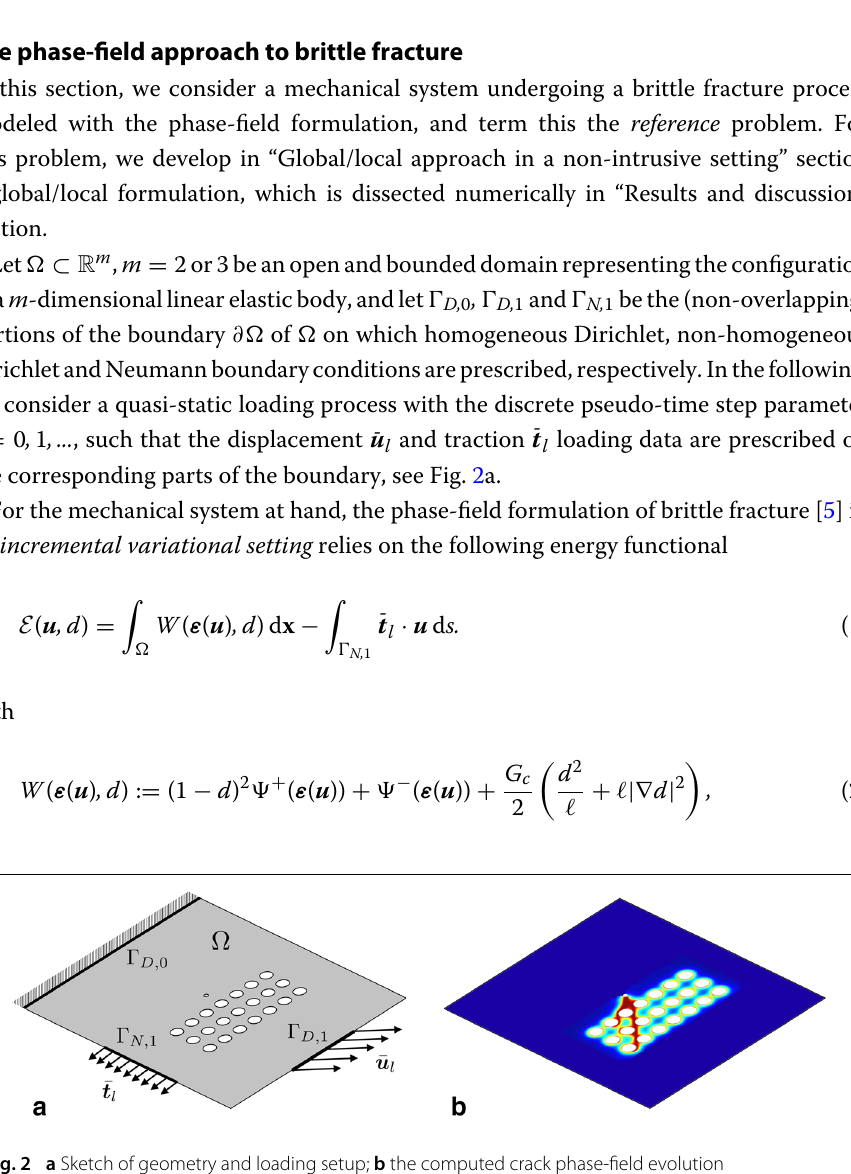
Fig. 2 a Sketch of geometry and loading setup; b the computed crack phase-field